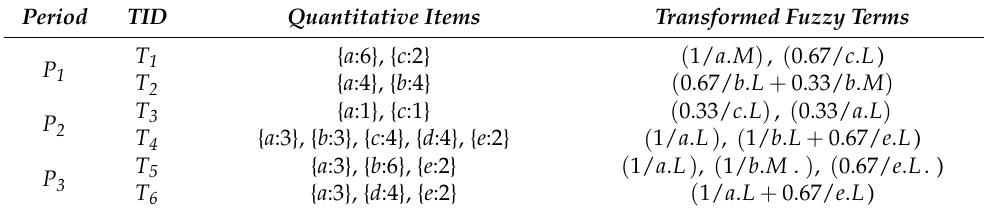
Table 1. An example of temporal quantitative transaction database.